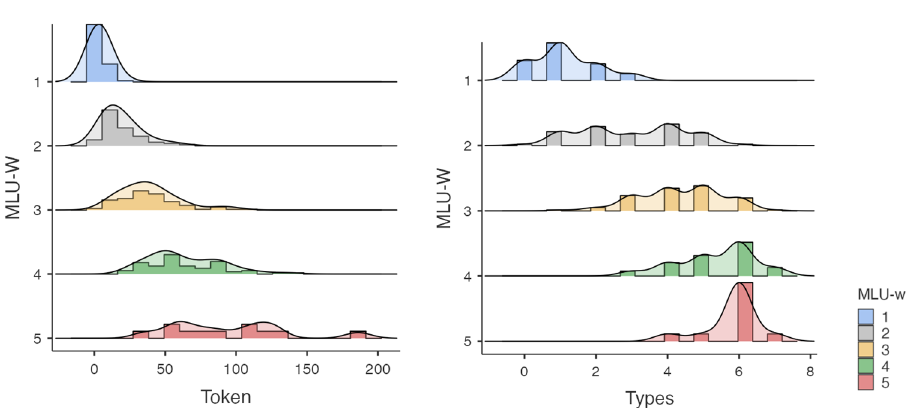
Figure 5. Histogram representing the raw number of word tokens and word types of subject pronouns according to MLU-w e.g., “il/elle/on/je/tu/ils/elles”(he/she/it/I/you/they-masuline/they-feminine)